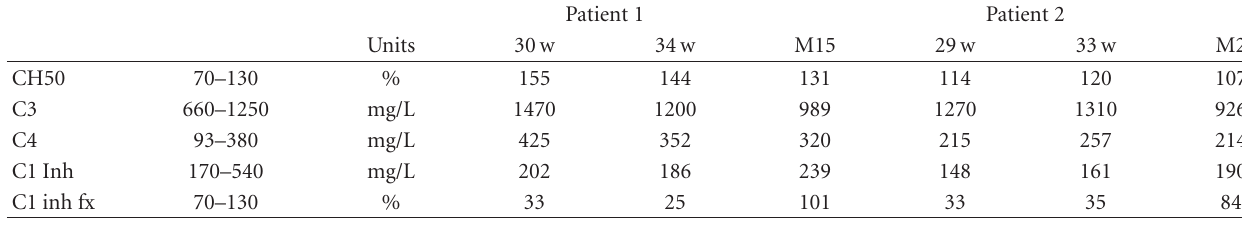
Table 1: Complement profiles in patients. The diagnosis of patient 1 was reviewed two years after the fourth pregnancy. Complement was quantified for patient 1 at 30 and 34 weeks of gestation (W) and 15 months after the pregnancy (M15) and for patient 2 at 29 weeks and 33 weeks of gestation and 2 months after the pregnancy (M2). Plasma concentrations of C1 inhibitor (C1 inh), C4, and C3 were determined by nephelemetry (Dade Behring). Normal values ranged between 170 and 540 mg/L for C1-inhibitor (C1 Inh), 93 and 380 mg/L for C4, and 660 and 1250 mg/L ( ± 2 SD) for C3. CH50 were determined according to standard procedures. Results are expressed as percent of the CH50 of the reference plasma pool (obtained from one hundred healthy blood donors). C1-inhibitor function (C1 inh fx) was assessed in a chromogenic assay (Technochrom, Biolys, Taluyers, France).